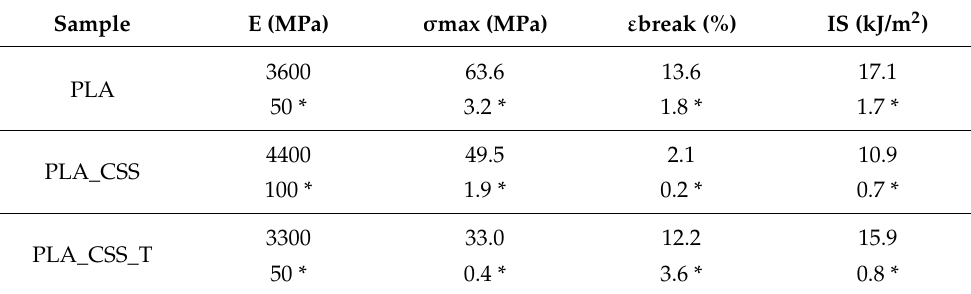
Table 4. Mechanical properties, from the tensile tests, of the investigated materials. Sample E